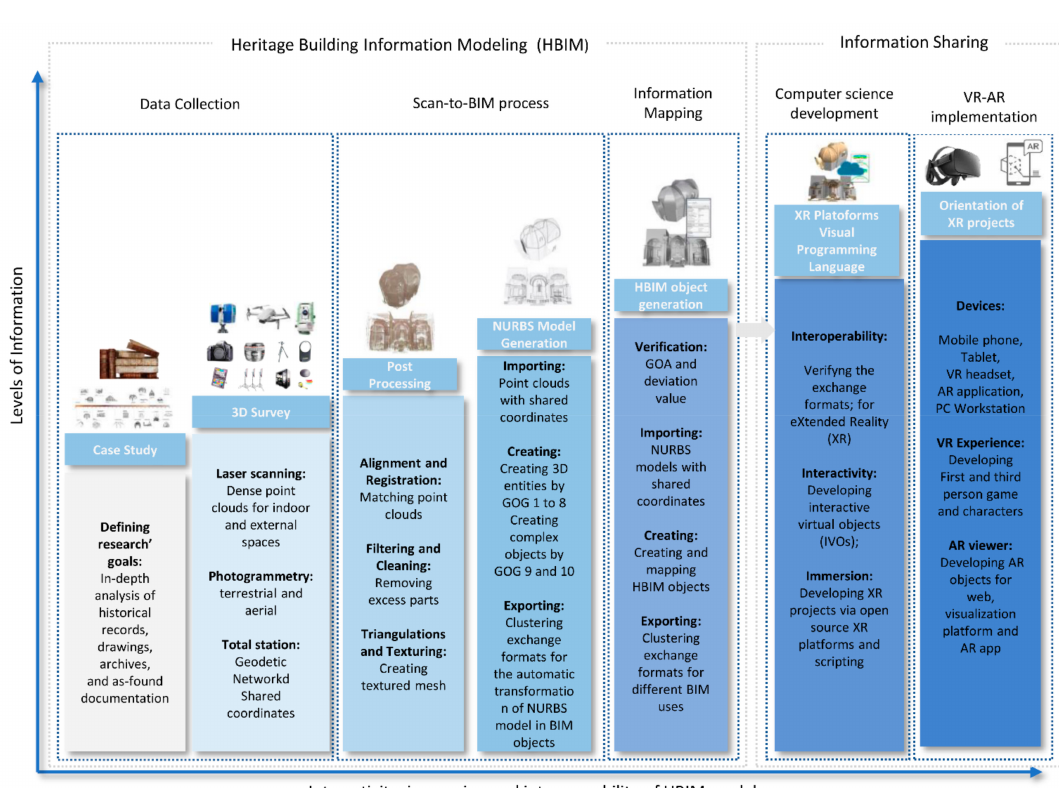
Figure 1. Proposed approach: from data collection and HBIM uses to VR-AR